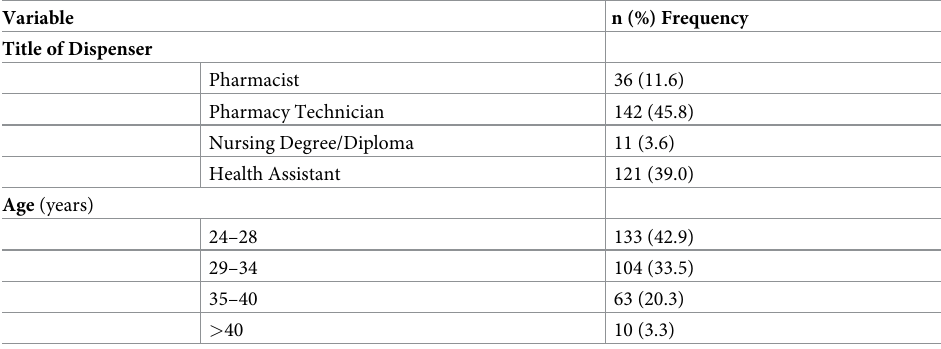
Table 1. Sociodemographic characteristics of the dispenser.